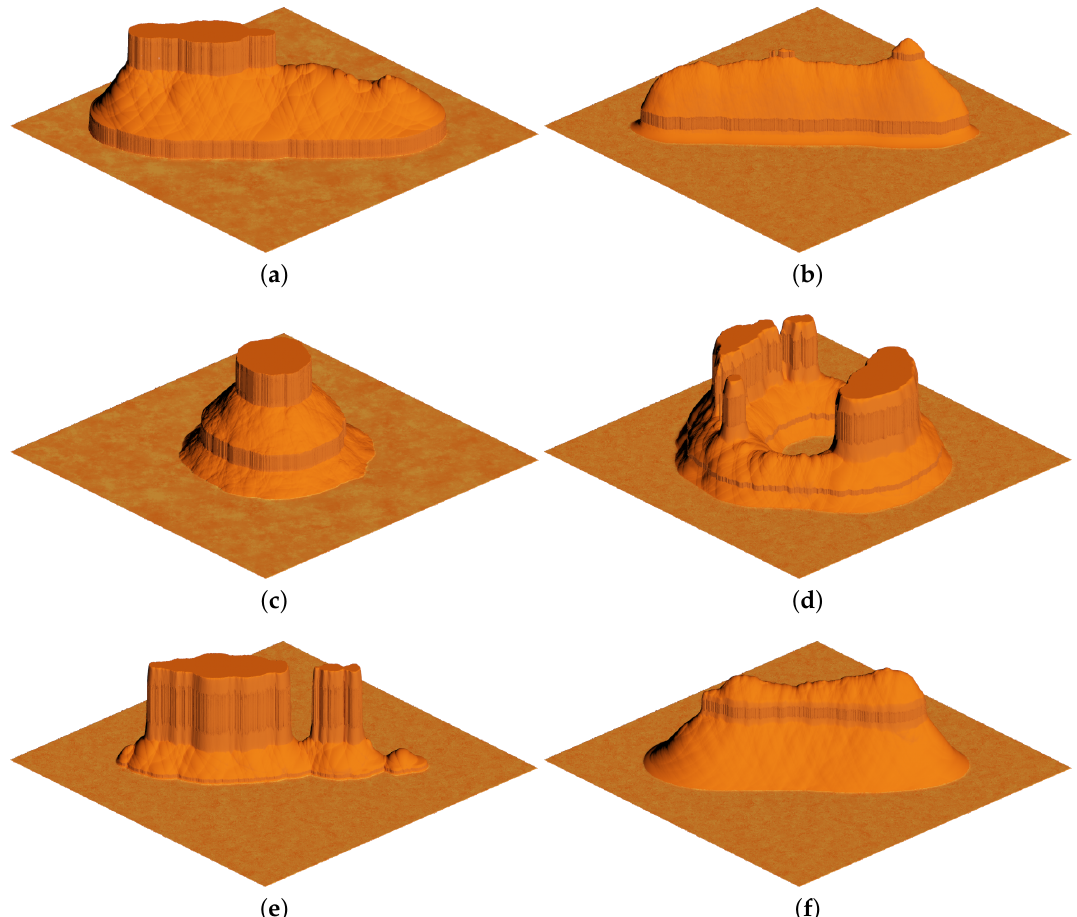
Figure 21. Examples of butte-like assets obtained by the proposed techniques (grid resolution: 1024 × 1024). ( a ) Fault radius: 1 (cid:54) r (cid:54) 300; total faults: 100 along x-axis; mat = 3. Erosive model was obtained for E = 0.45 with caprock and (cid:36) = 1. ( b ) Fault radius: 1 (cid:54) r (cid:54) 150; total faults: 999 along x-axis; mat = 4. Erosive model was obtained for E = 0.45 without caprock and (cid:36) = 25. ( c ) Fault radius: 1 (cid:54) r (cid:54) 250; total faults: 350 around model centre; mat = 4. Erosive model was obtained for E = 0.30 with caprock and (cid:36) = 1. ( d ) Fault radius: 1 (cid:54) r (cid:54) 250; total faults: 150 around model centre; mat = 4. Erosive model was obtained for E = 0.35 with caprock and (cid:36) = 10. ( e ) Fault radius: 1 (cid:54) r (cid:54) 250; total faults: 75 along x-axis; mat = 4. Erosive model was obtained for E = 0.65 with caprock and (cid:36) = 5. ( f ) Fault radius: 1 (cid:54) r (cid:54) 250; total faults: 250 along x-axis; mat = 3. Erosive model was obtained for E = 0.35 without caprock and (cid:36) =